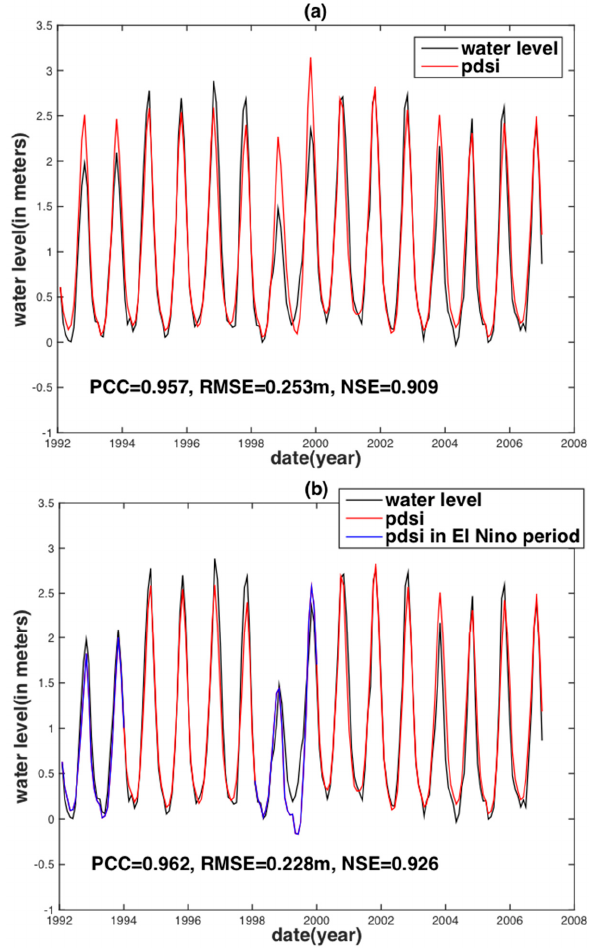
Figure 7. The water level reconstruction at the Vam Kenh station based on the downstream PDSI ( a ) and ENSO-assisted PDSI ( b ).